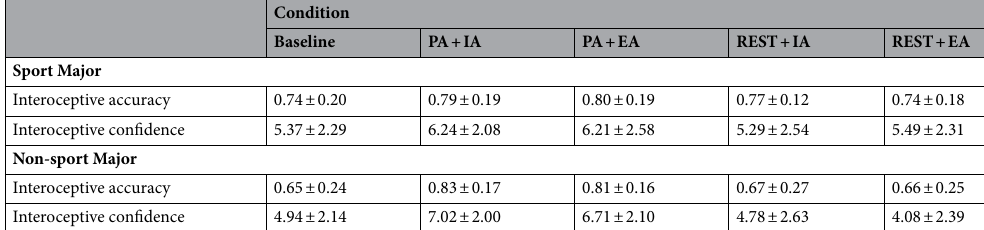
Table 3. Means and standard deviations for interoceptive accuracy (IAcc) and interoceptive confidence scores at baseline and across all four conditions, with participants split by sporting background (students majoring in sport vs non-sport focussed